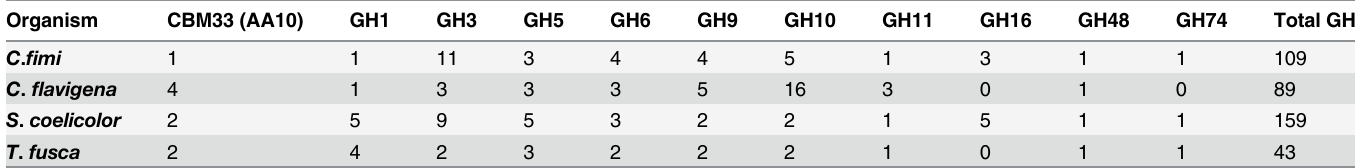
Table 1. Known cellulase and xylanase families in related actinobacteria. Families are from the CAZy database (http://www.cazy.org/Glycoside- Hydrolases.html). The total GH number does not include pectin